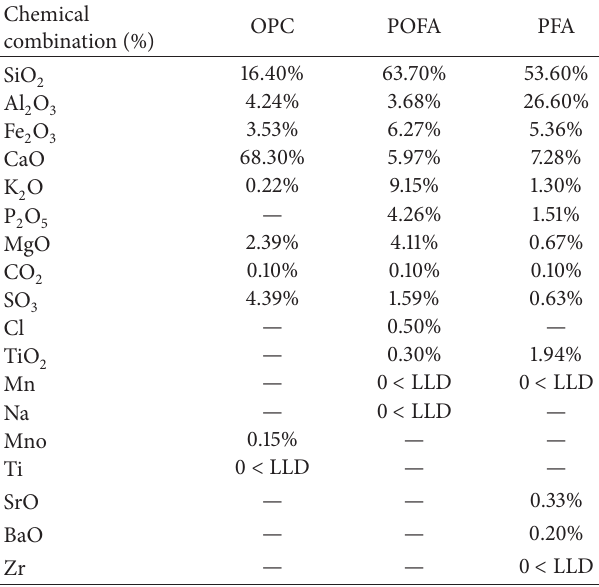
Table 1: Chemical composition of OPC, POFA, and